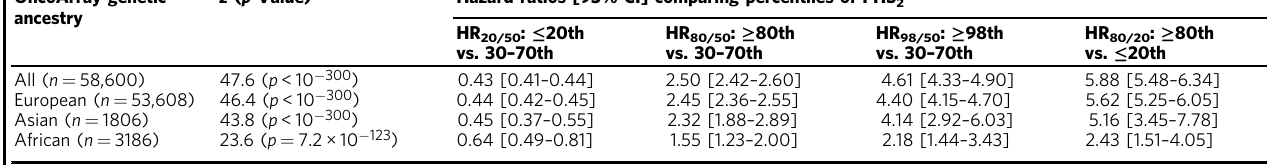
Table 2 Association of PHS with aggressive prostate cancer. OncoArray genetic ancestry